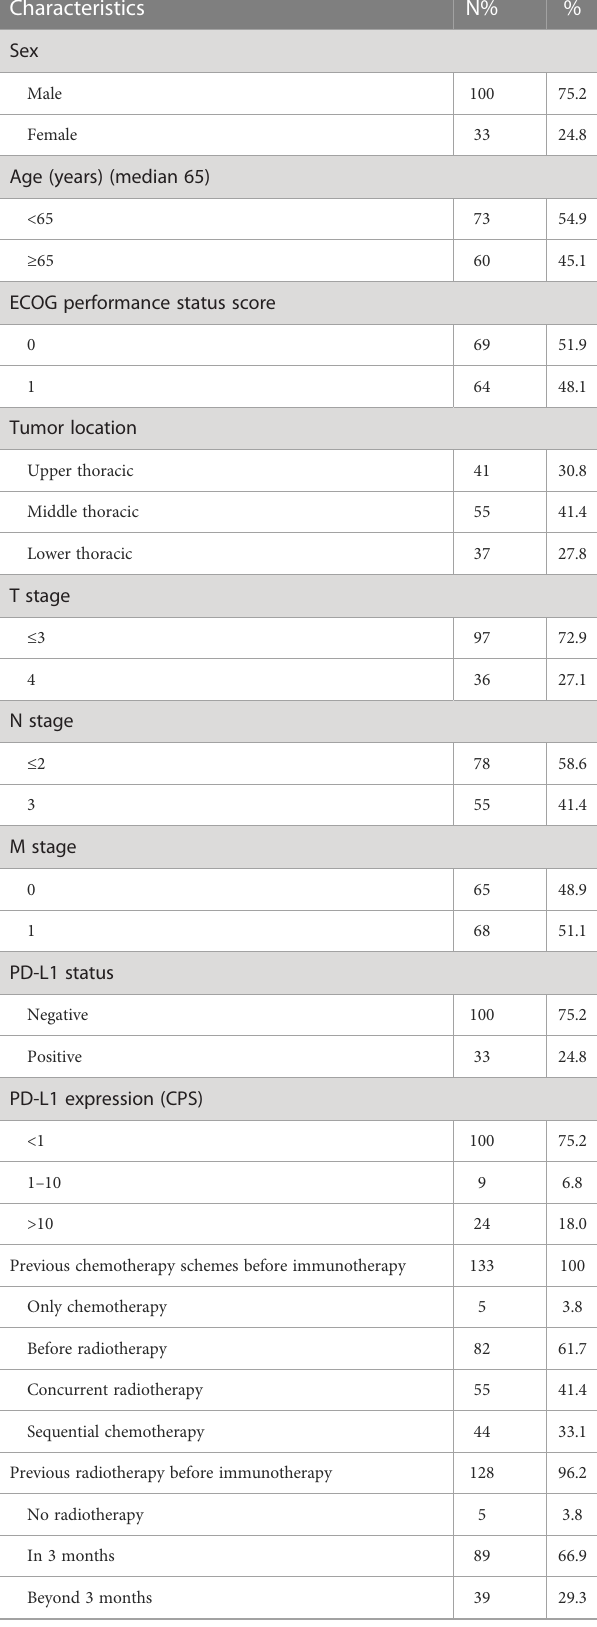
Of 133 patients, 15 patients experienced a partial response, and 14 patients had stable disease. The ORR was 11.3% and the DCR was 45.9% (Table 3). A total of 72 patients experienced disease progression, and the median PFS with sintilimab treatment was 9.0